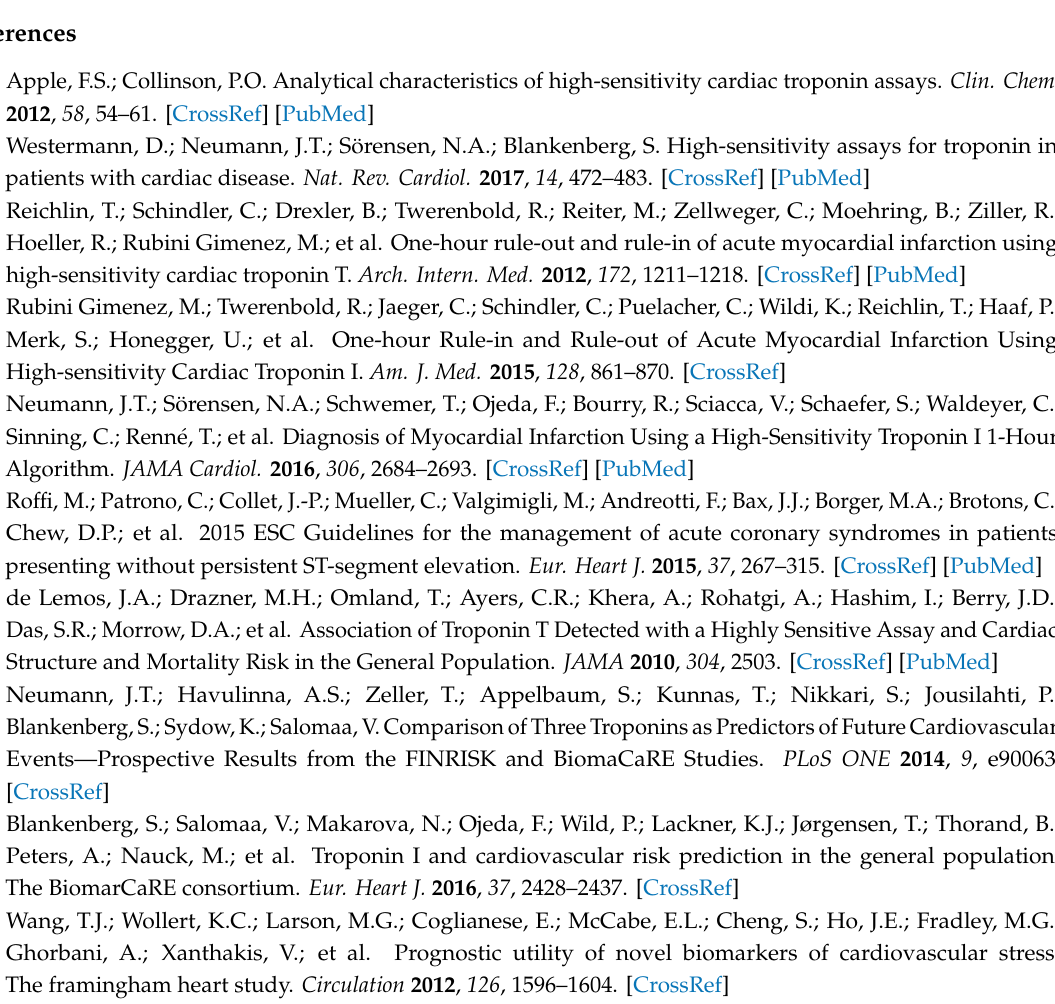
Table S2: Patient characteristics of patients with the final diagnosis of AMI according to thirds of troponin levels analyzed by both assays; Table S3: Patient characteristics of patients with the final diagnosis of non-AMI according to thirds of troponin levels analyzed by both assays; Figure S1: Survival analysis according to thirds of troponin levels in patients with AMI; Figure S2: Survival analysis according to thirds of troponin levels in patients without AMI; Figure S3: Correlation of both hs-TnI assays; Figure S4: Bland-Altman analysis for comparison of both hs-TnI